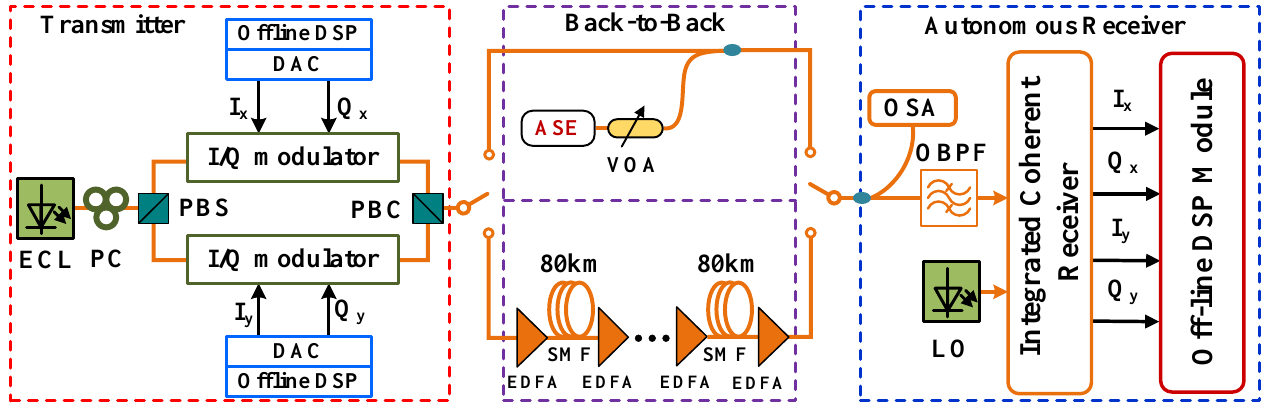
Figure 15. Proof-of-concept experimental setup of the proposed scheme. PC: polarization controller, PBS: polarization beam splitter, PBC: polarization beam coupler, VOA: variable optical attenuator, LO: local oscillator.